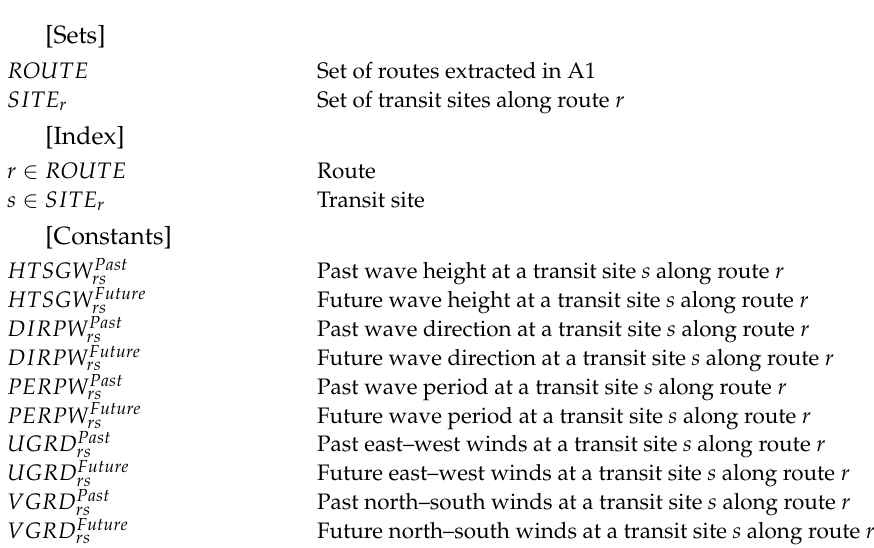
Figure 6. Graphical image of quantification.